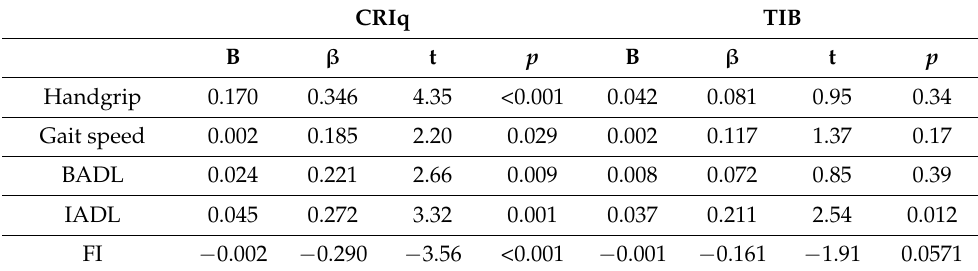
Table 2. Associations of CR and premorbid IQ with functional variables.